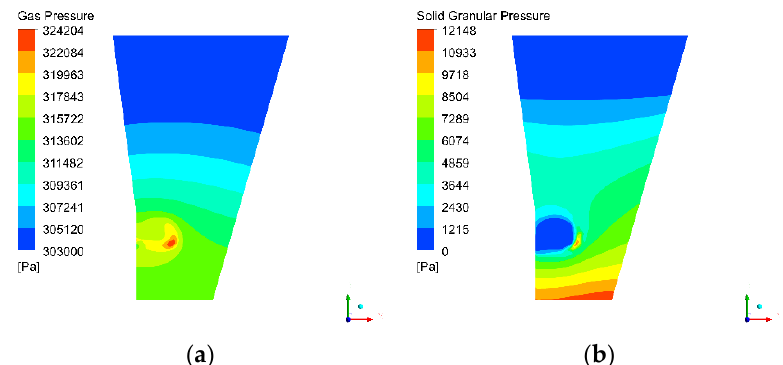
Figure 6. ( a ) Gas pressure and ( b ) solid granular pressure for Case 3 in the symmetry plane at 40 s.